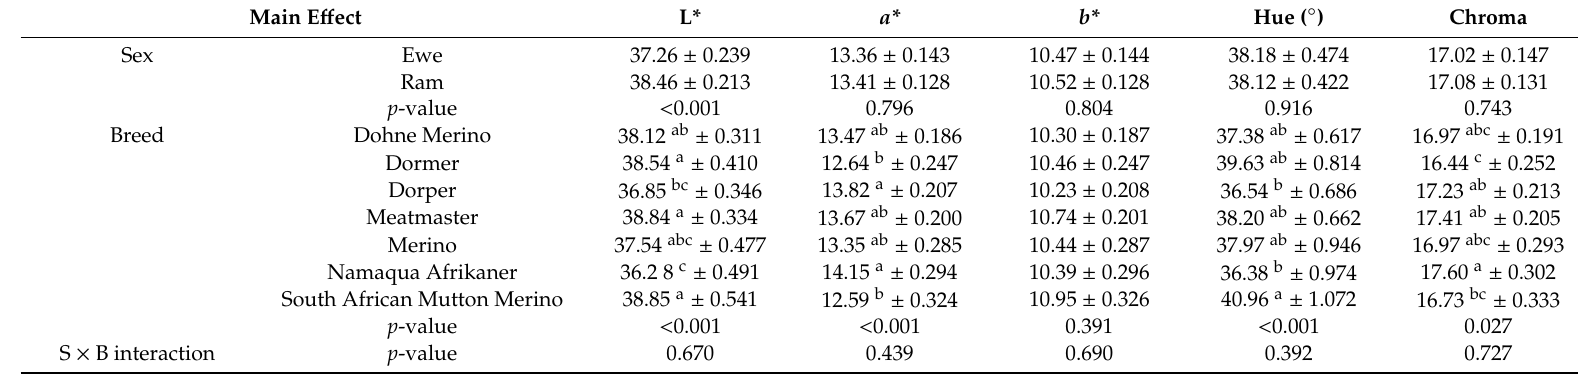
Table 7. Meat colour characteristics of longissimus lumborum muscles excised from A2 carcasses depending on the e ff ects of lamb sex and breed expressed as the least square means ± standard